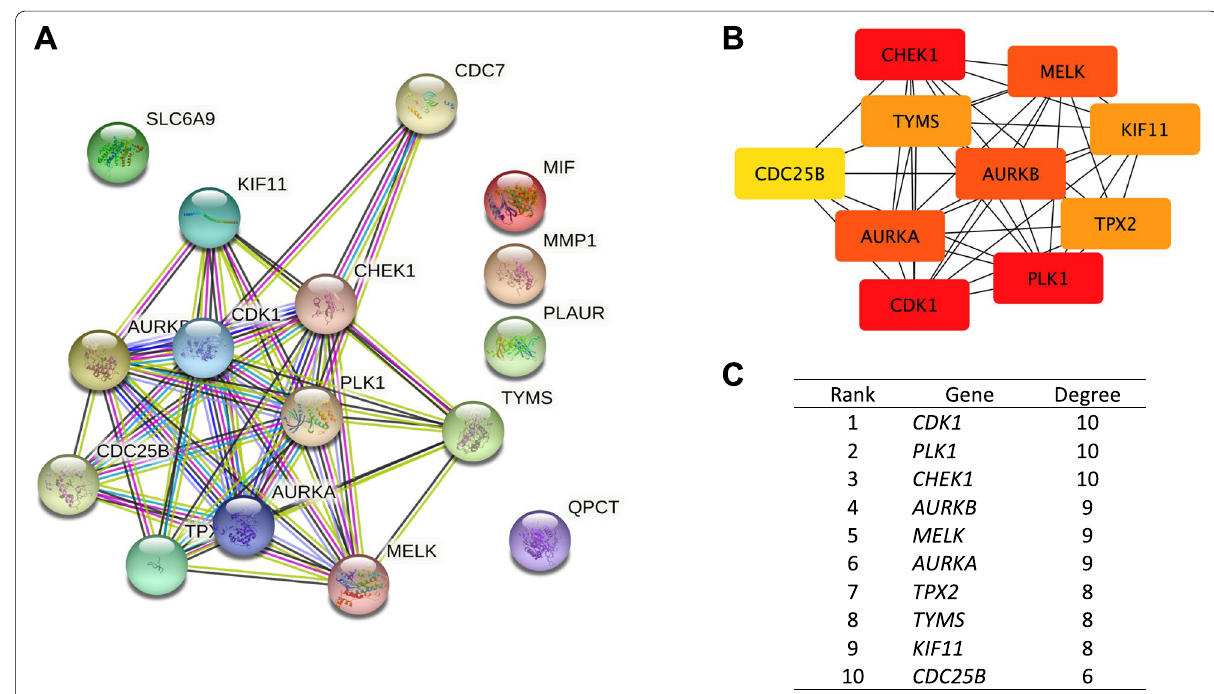
Fig. 4 ( A ) The protein–protein interaction of CPTGs established in STRING. ( B ) The top ten genes of CPTGs were selected based on the highest degree score visualized in Cytohubba in Cytoscape. ( C ) The rank list from the top ten CPTGs genes